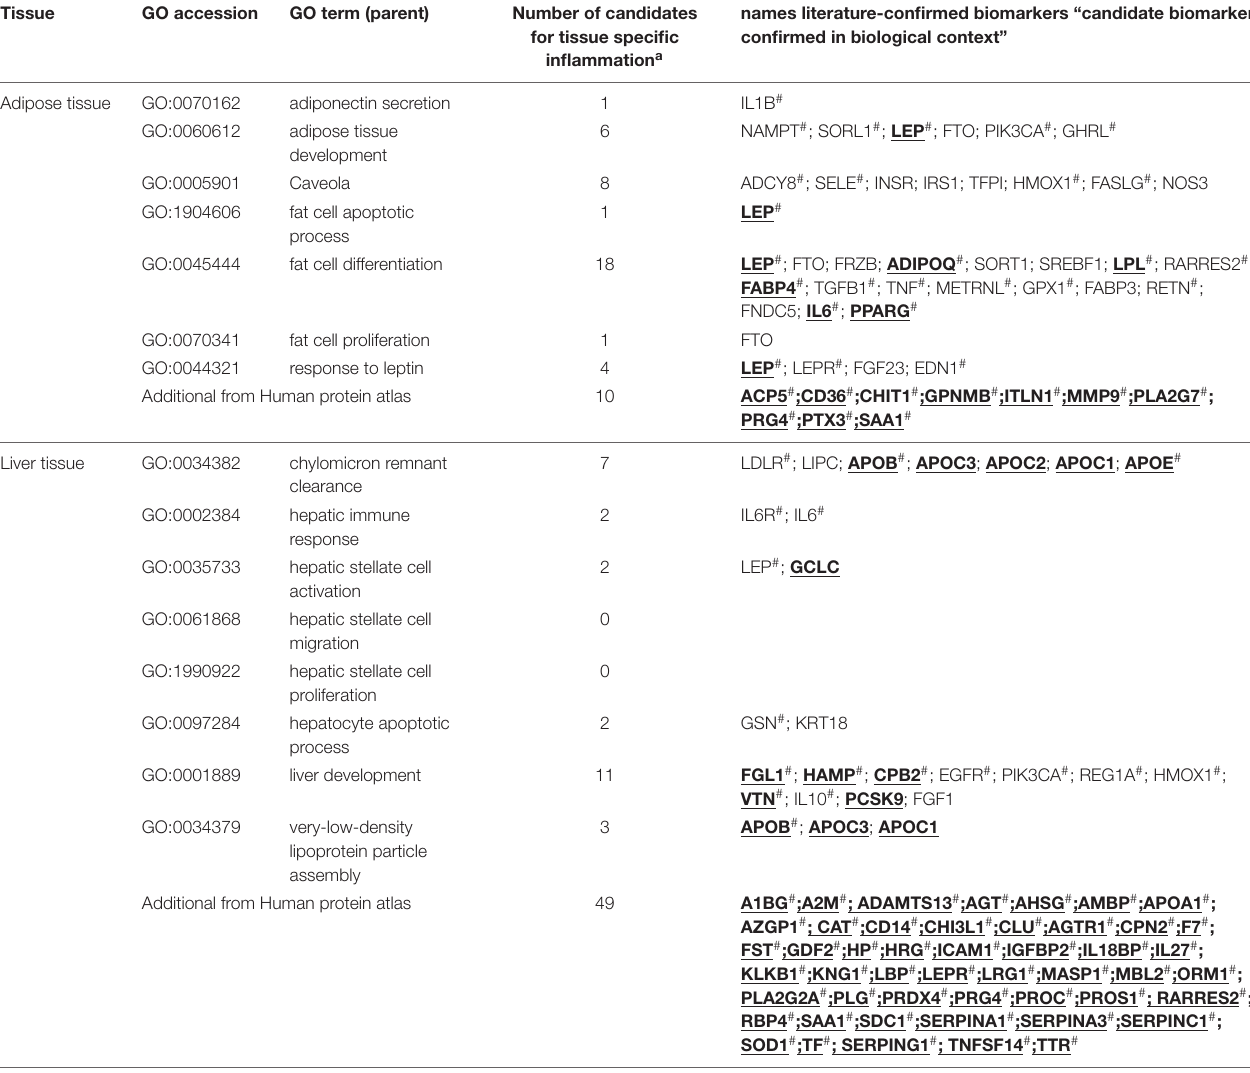
for tissue specific inflammation a